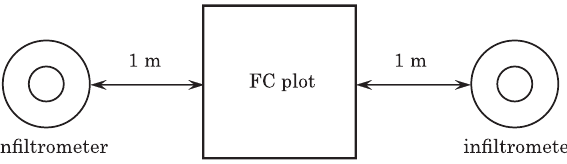
Figure 1. Diagram of the experimental setup for double ring infiltrometers and field capacity (FC) plot at a given